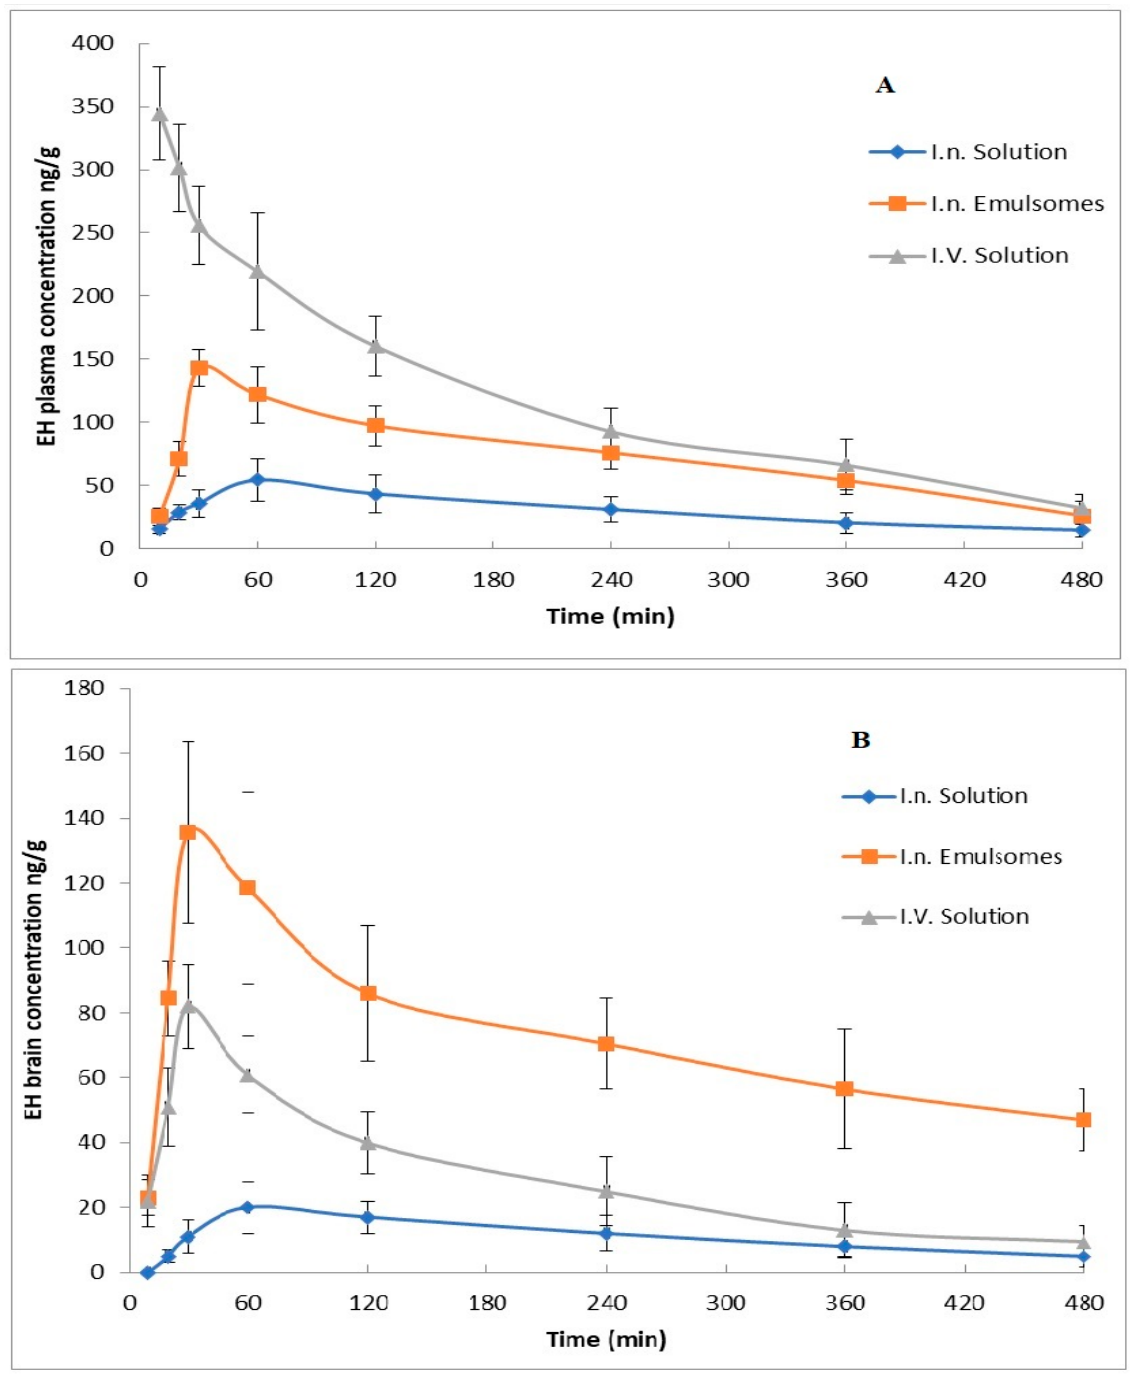
Figure 5. ET concentrations in mice after administration of various formulations: ( A ) plasma concentrations, ( B ) brain concentrations. Table 6. EH hydrobromide pharmacokinetic parameters in plasma and brain.